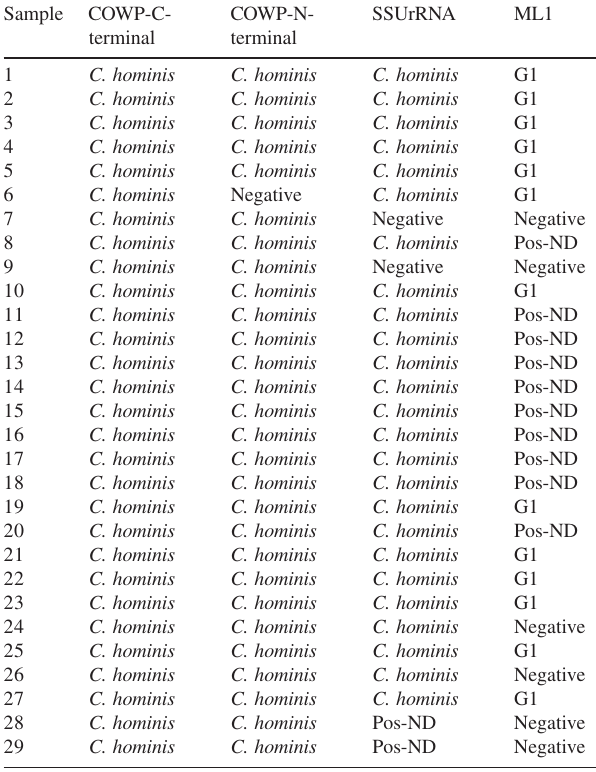
Table 1 - Analysis of 29 stool samples positive for Cryptosporidium collected from children attending in the day care at the Clinical Hospital, Sao Paulo Brazil Sample